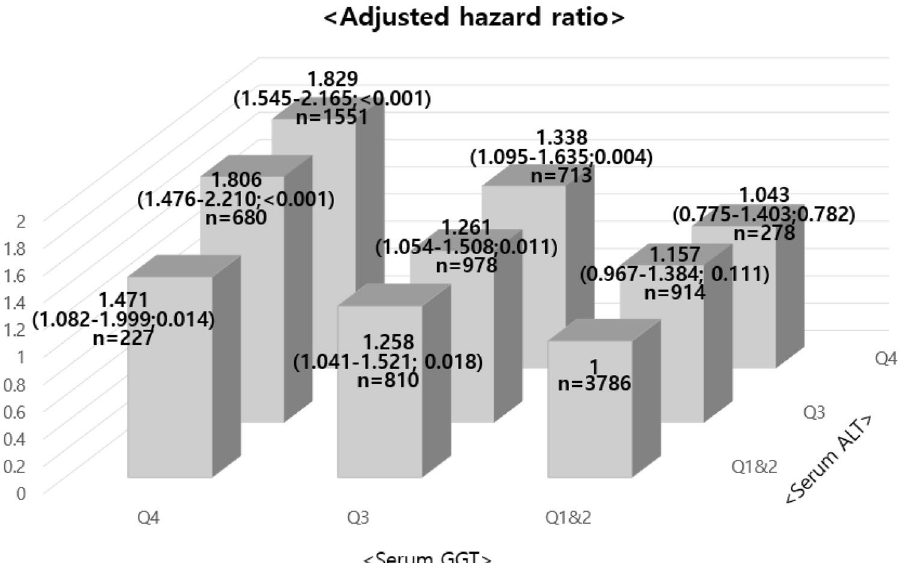
Figure 1. Adjusted hazard ratios * (95% confidence interval; P ) for the development of impaired fasting glucose according to the combined categories of ALT and GGT levels (1st and 2nd quartiles, 3rd quartile, and 4th quartile) in cross-sectional analysis. * The model was adjusted for age, gender, body mass index, log-transformed weekly alcohol consumption, current smoker, hypertension, hyperlipidemia, and uric acid. Q1 1st quartile, Q2 2nd quartile, Q3 3rd quartile, Q4 4th quartile, ALT alanine aminotransferase, GGT